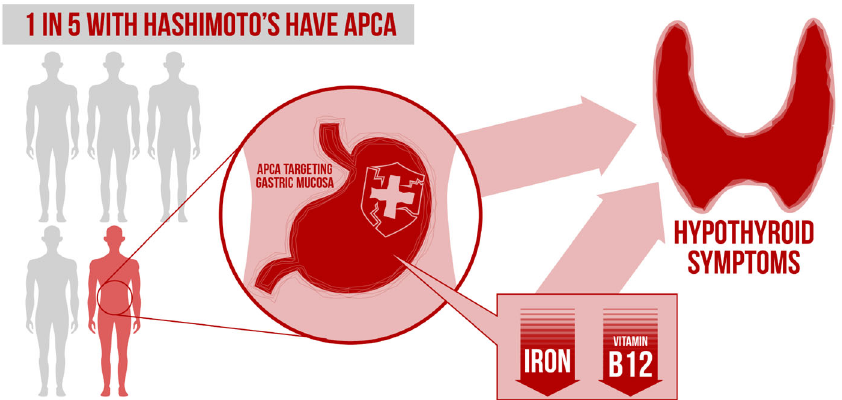
Figure 1. Relationship between Hashimoto’s, parietal cell antibodies, nutrient deficiencies, and ap ‐ parent thyroid symptoms. apparent thyroid